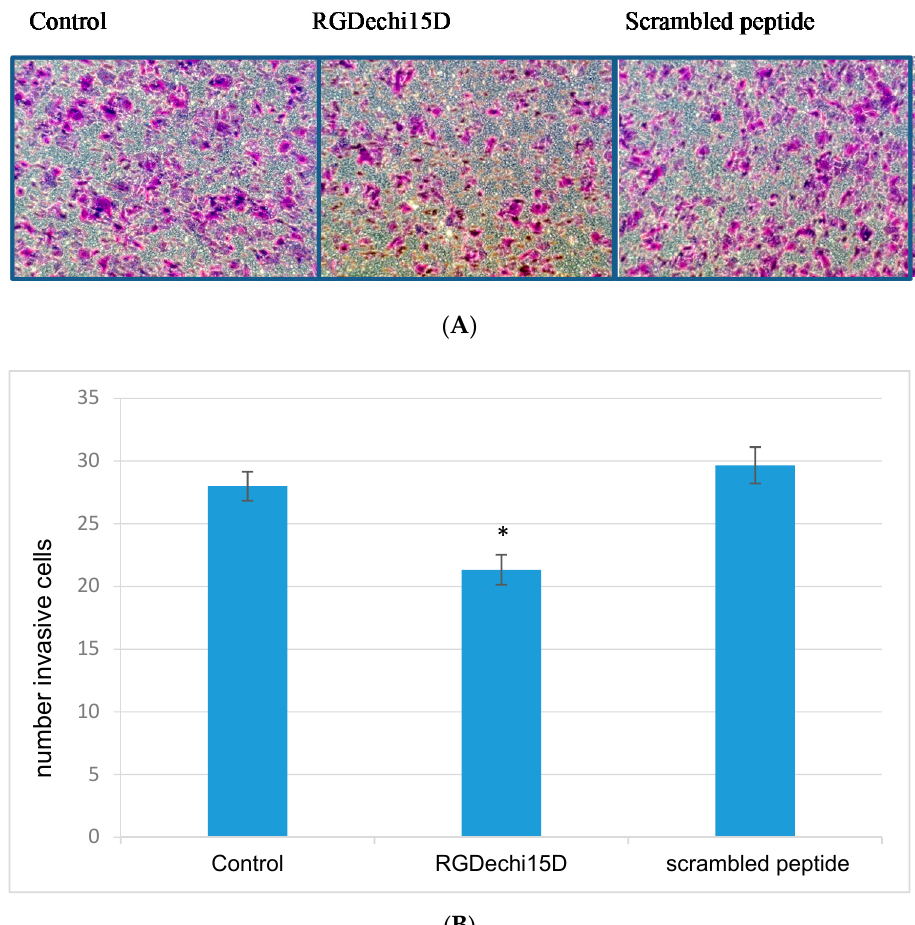
Figure 5. Inhibition of HepG2 invasion by RGDechi15D. ( A ) The invasion of HepG2 cells was assessed in trans-well chambers coated with ECL Cell Attachment. Invaded cells were fixed, stained, and captured at 20× magnification. The picture is representative of three independent experiments performed in duplicate. ( B ) The invasive HepG2 cells were counted and their number (± SE) was reported in the scheme (* p < 0.05).